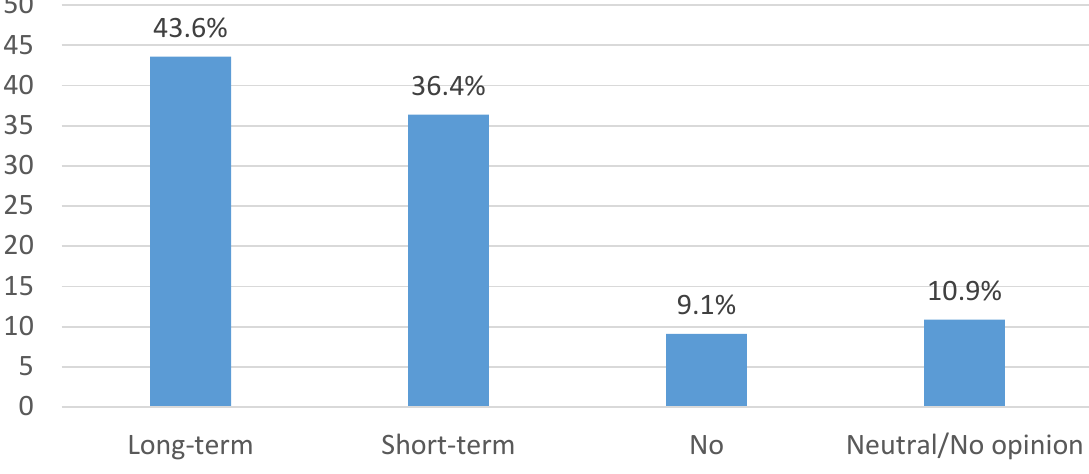
Figure 2. Benefits that FIFA sporting events bring to the